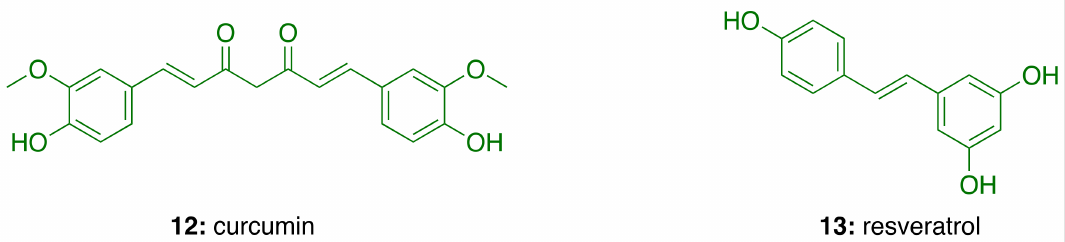
Figure 3. Structures of anti-Alzheimer’s natural products.